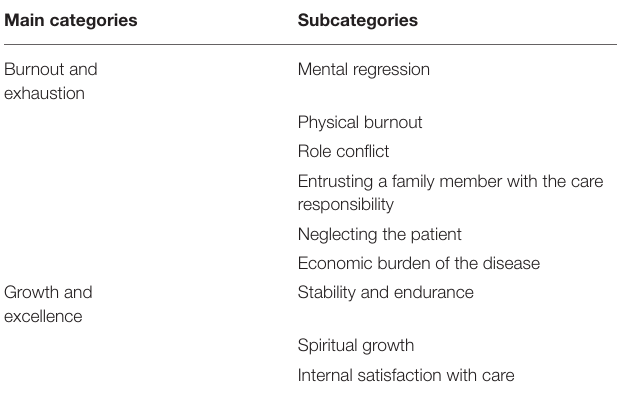
TABLE 3 | Theme, main categories, and subcategories from the conventional content analysis of the interviews. Main